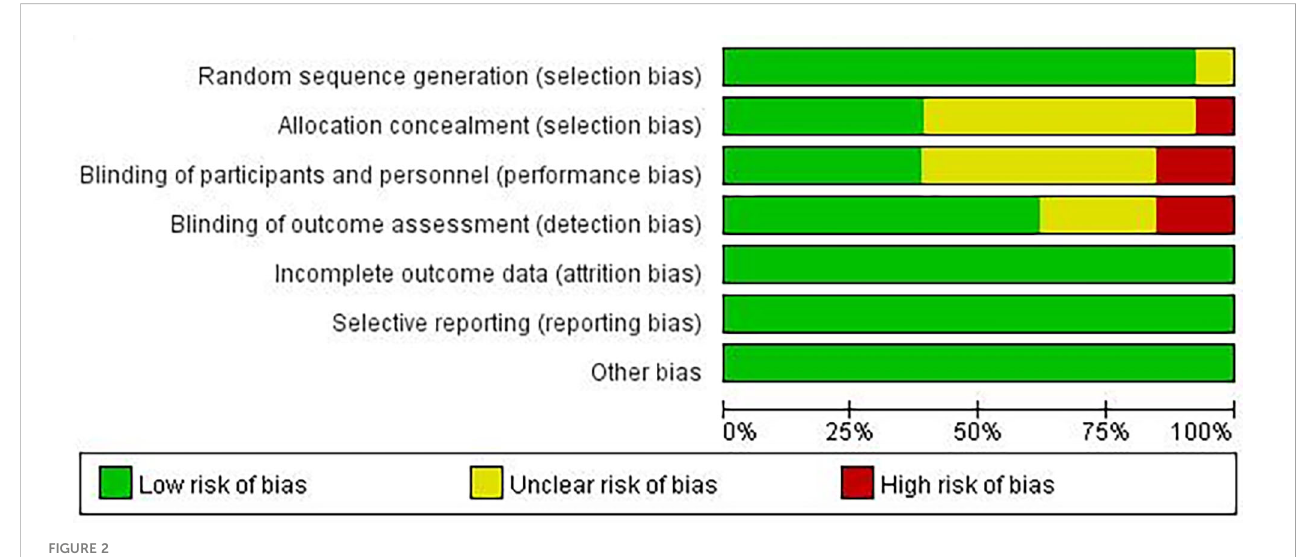
FIGURE 2 Risk of bias